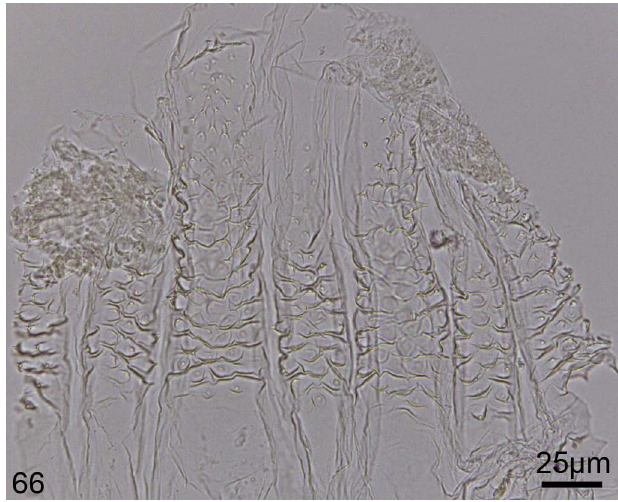
Fig 66. Enteric valve armature of Termes fatalis .